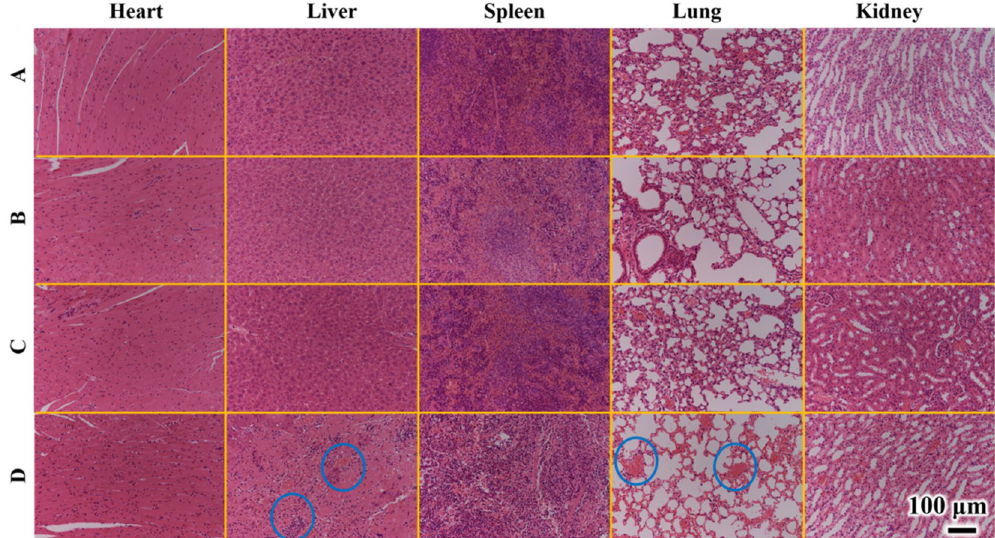
Figure 8. H&E-stained images of main organs (heart, liver, spleen, lung, kidney) from the different treatments PhIP (A, B, C, D represents 10, 20, 50, 100 μg/mL) for 30 days exposure of